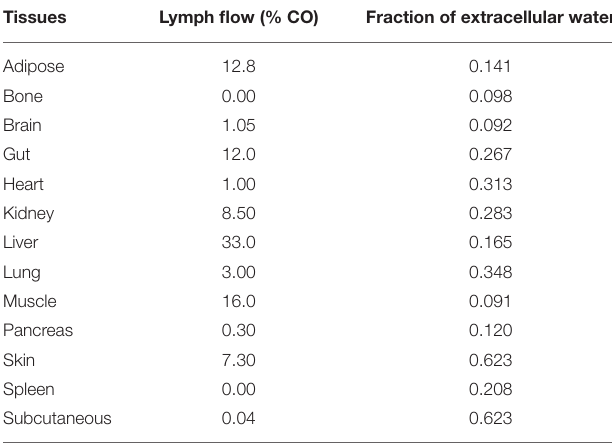
TABLE 2 | Lymph flow draining various tissues in the human body (44).